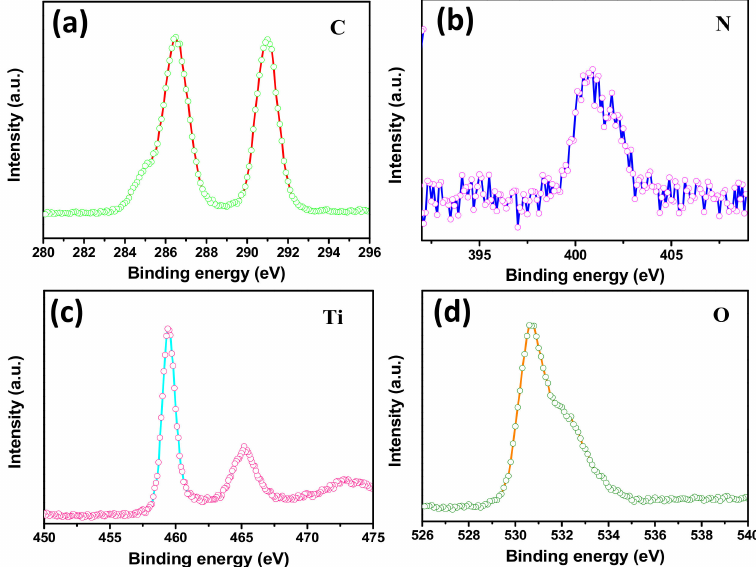
Figure 4. HR-XPS spectra of TPCN2 composite synthesized at 150 ◦ C for 24 h: ( a ) C 1s ( b ) N 1s, ( c ) Ti 2p and ( d ) O